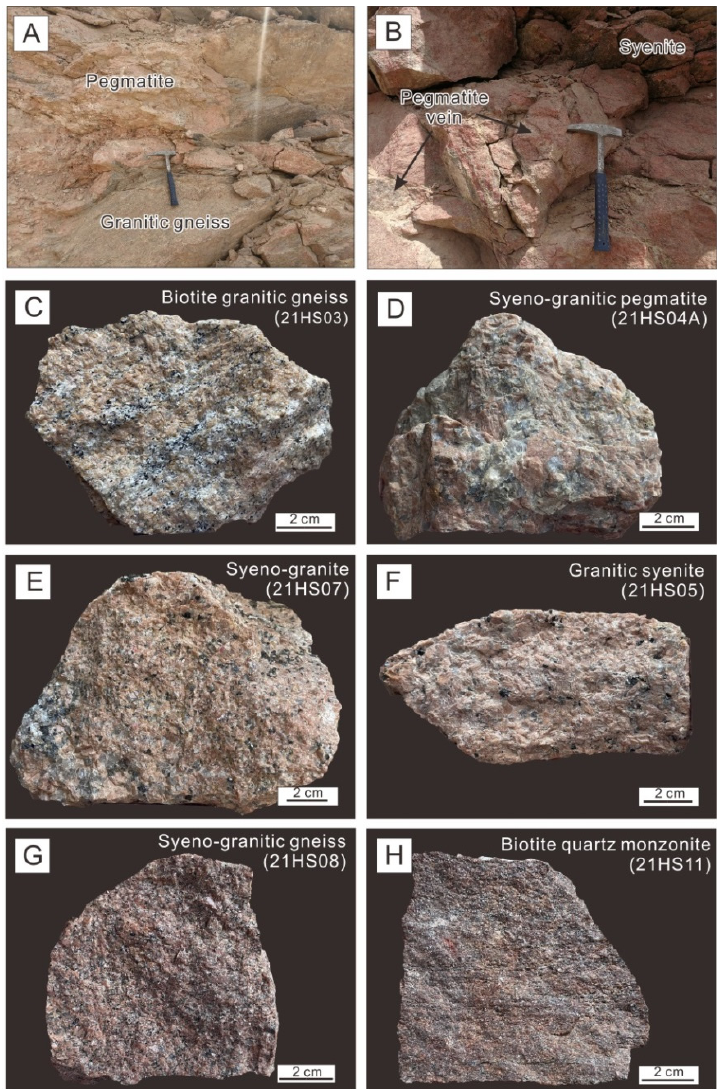
Figure 2. Representative hand specimen photographs of the AMC basement rocks. ( A ) Granitic gneisses are intruded by pink pegmatite; ( B ) syenite with pegmatite veins; ( C ) biotite granitic gneiss; ( D ) syeno-granitic pegmatite; ( E ) Syeno-granite; ( F ) granitic syenite; ( G ) syeno-granitic gneiss; ( H ) biotite quartz monzonite.